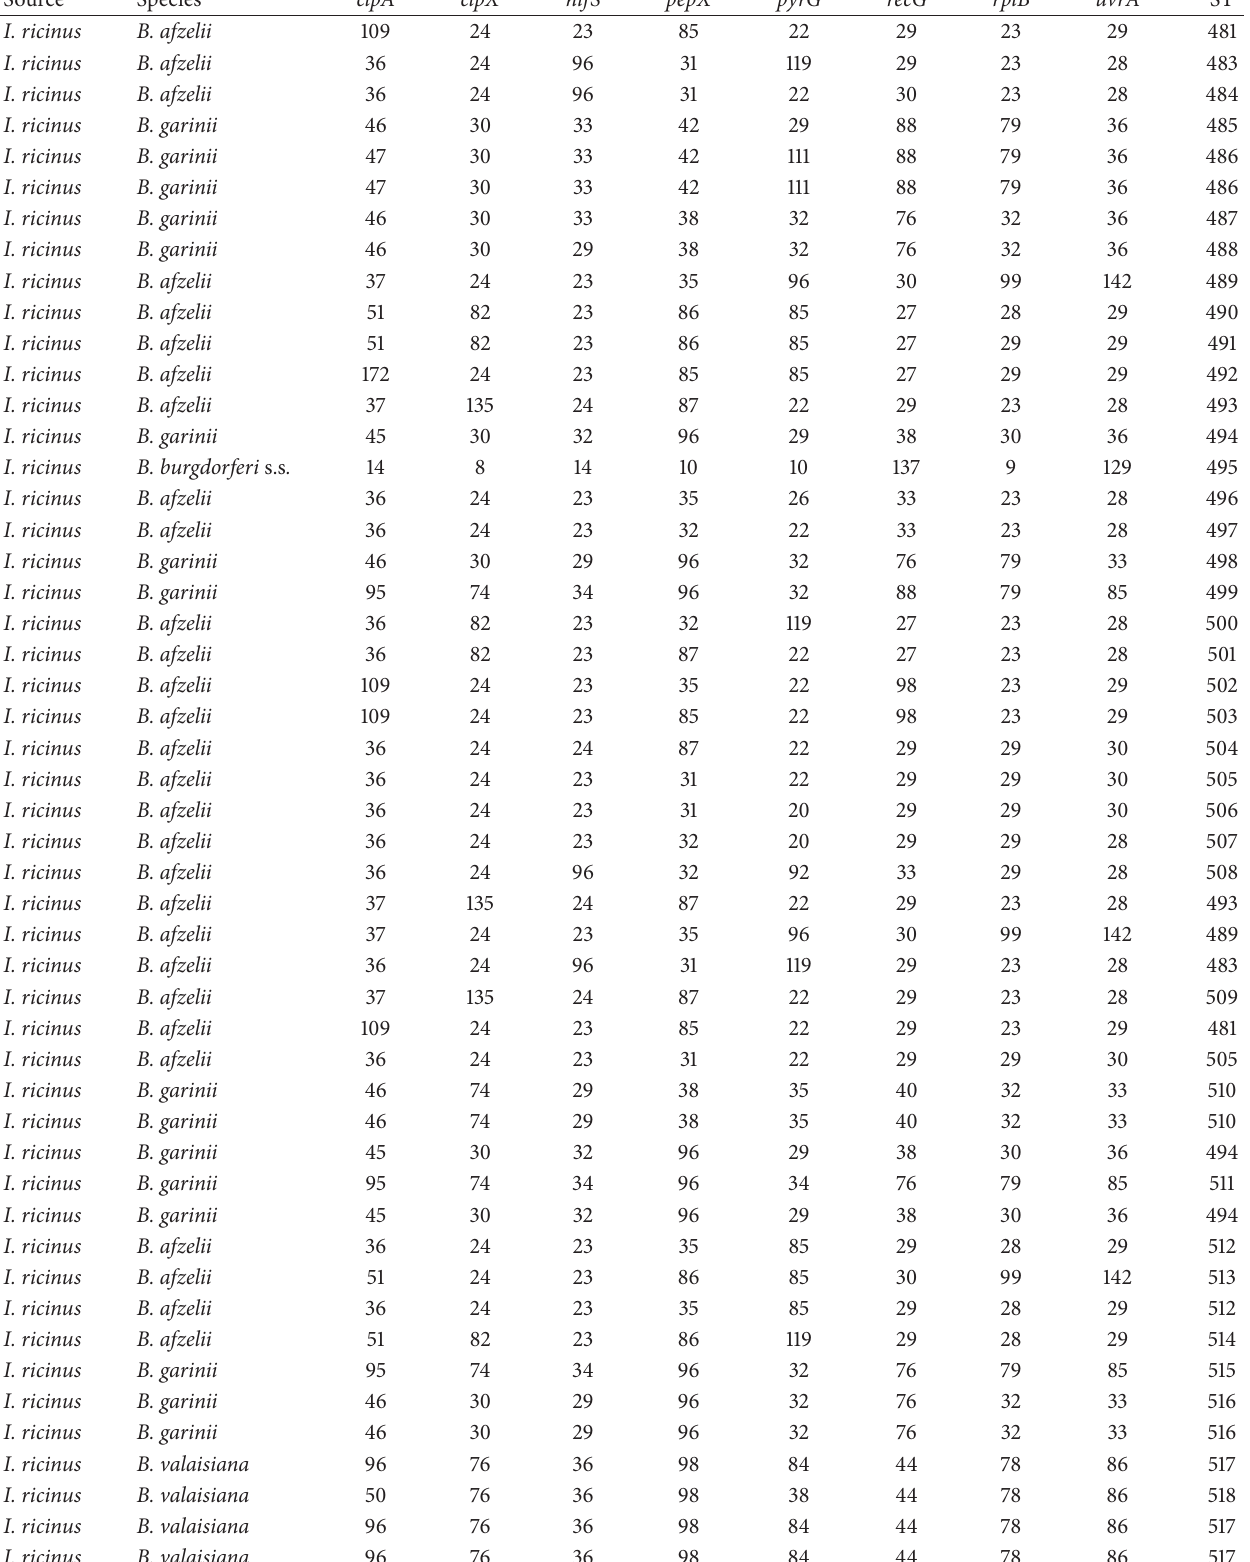
Table 1: Allele and sequence types